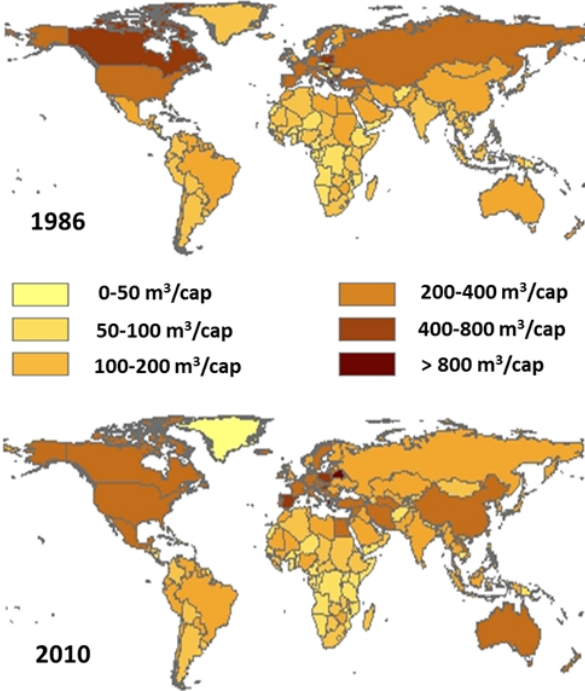
Fig. 3. National grey water footprints (per capita) in 1986 and 2010.